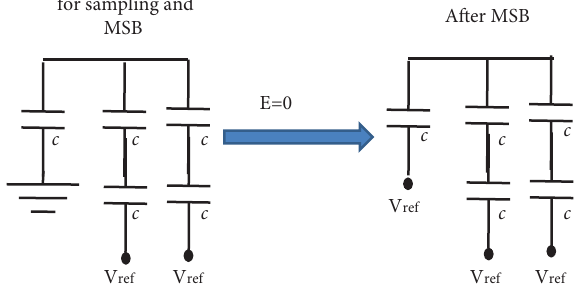
Figure 14: LSB split